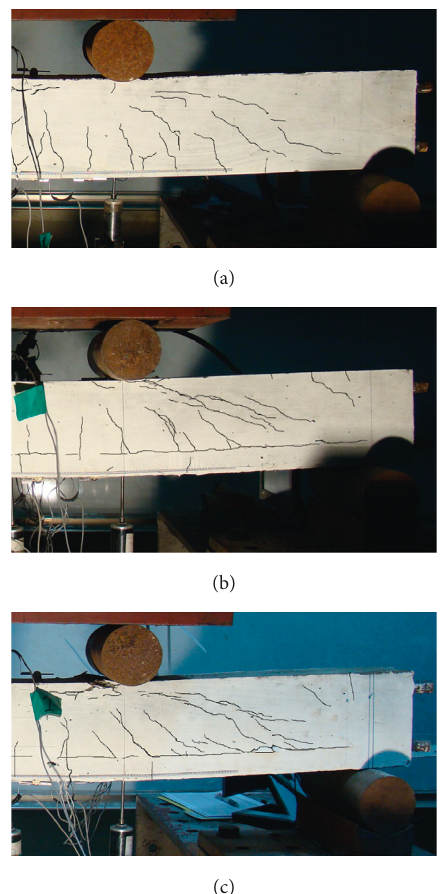
Figure 7: Failure modes and cracking patterns of RC beam specimens. (a) RC beam specimen. (b) RC-R (SHCC30) beam specimen. (c) RC- R (Ex-SHCC30) beam